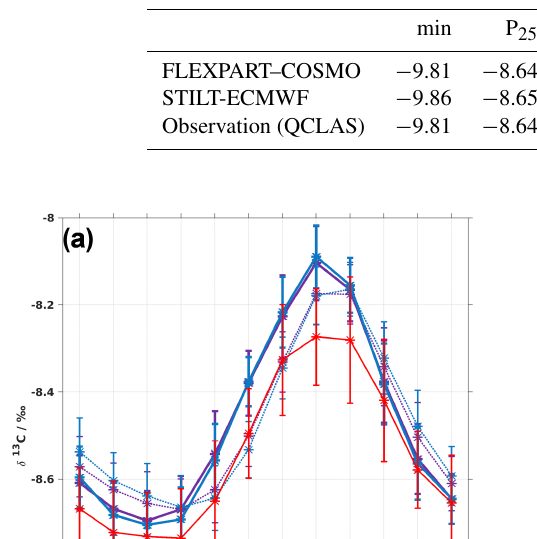
Table 4. Summary of statistics on atmospheric δ 13 C–CO 2 estimates and observations for the period 2012–2015. Values for min, max, median (P 50 ), 25th and 75th percentiles (P 25 and P 75 ), mean (avg), and 1SD are provided (hourly data) (see also Fig. S6).